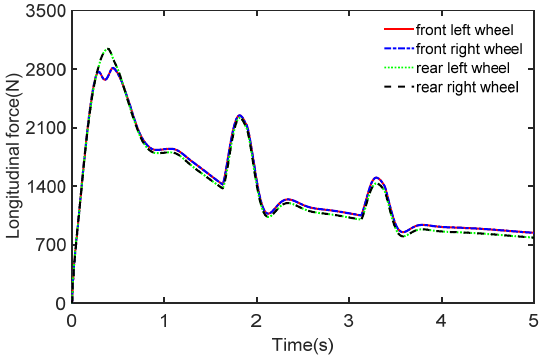
Figure 6. The tire forces in the case of acceleration.